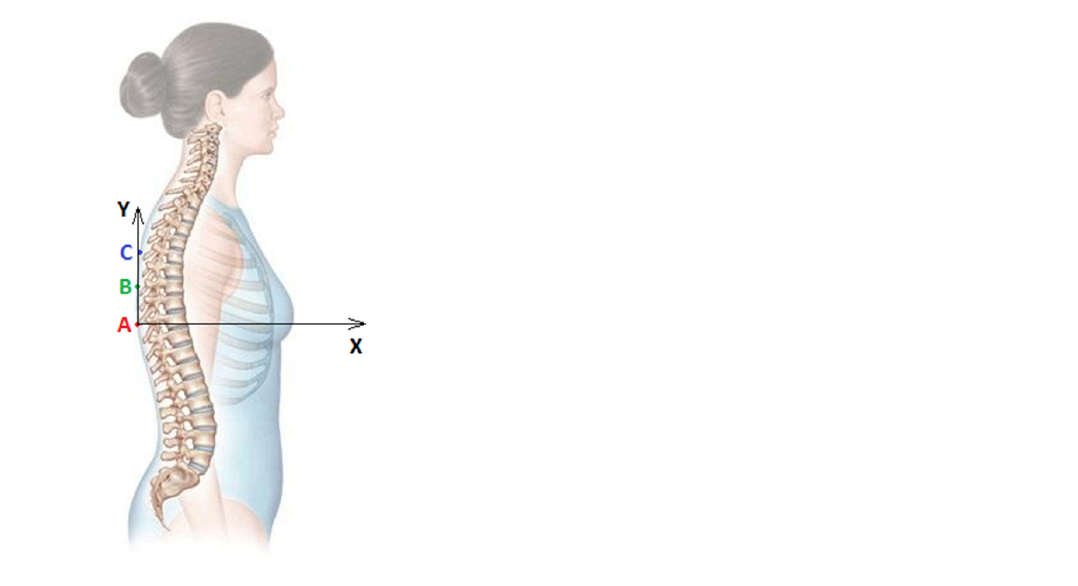
spine, approximately in the anatomical zone between T4 and T8.